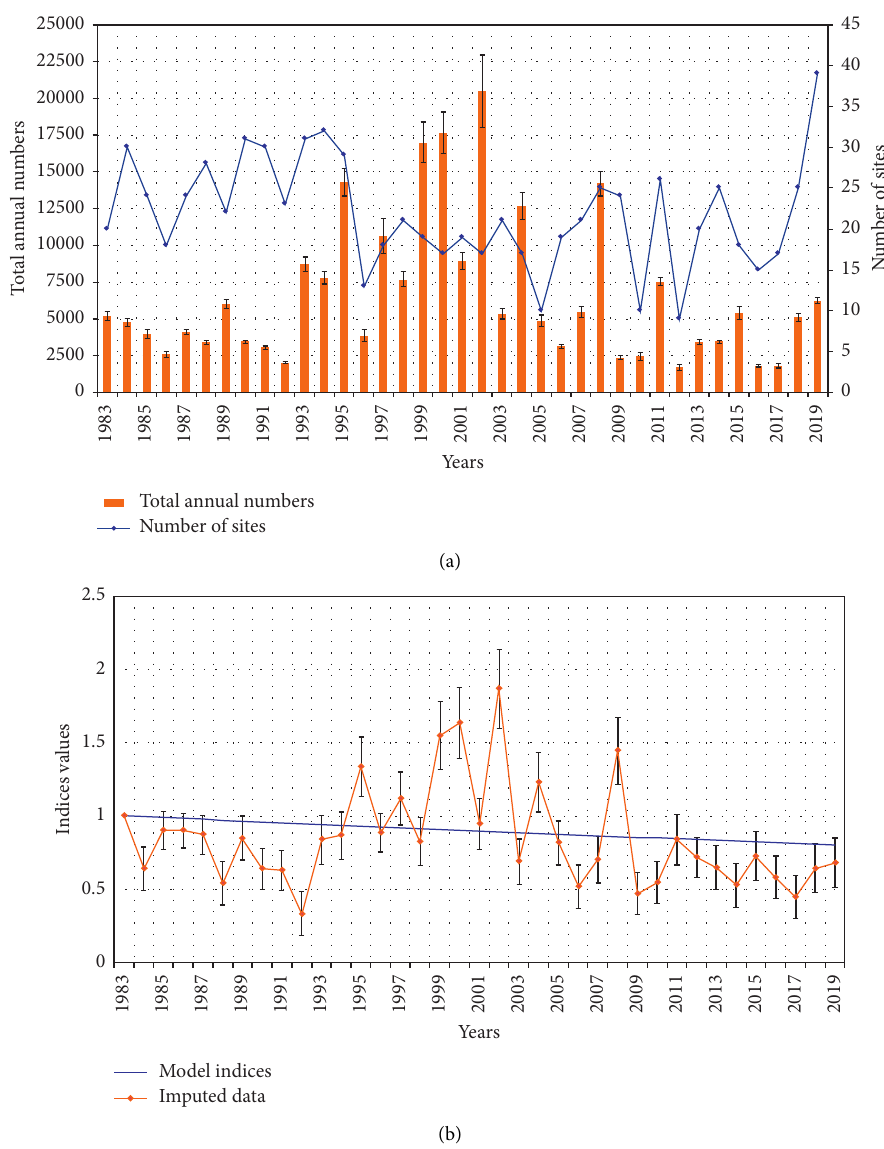
Figure 1: (a) Total annual numbers of the Common Pochard and number of wetlands where it has been observed in Morocco between 1983 and 2019. (b) Linear trend of the wintering population (TRIM